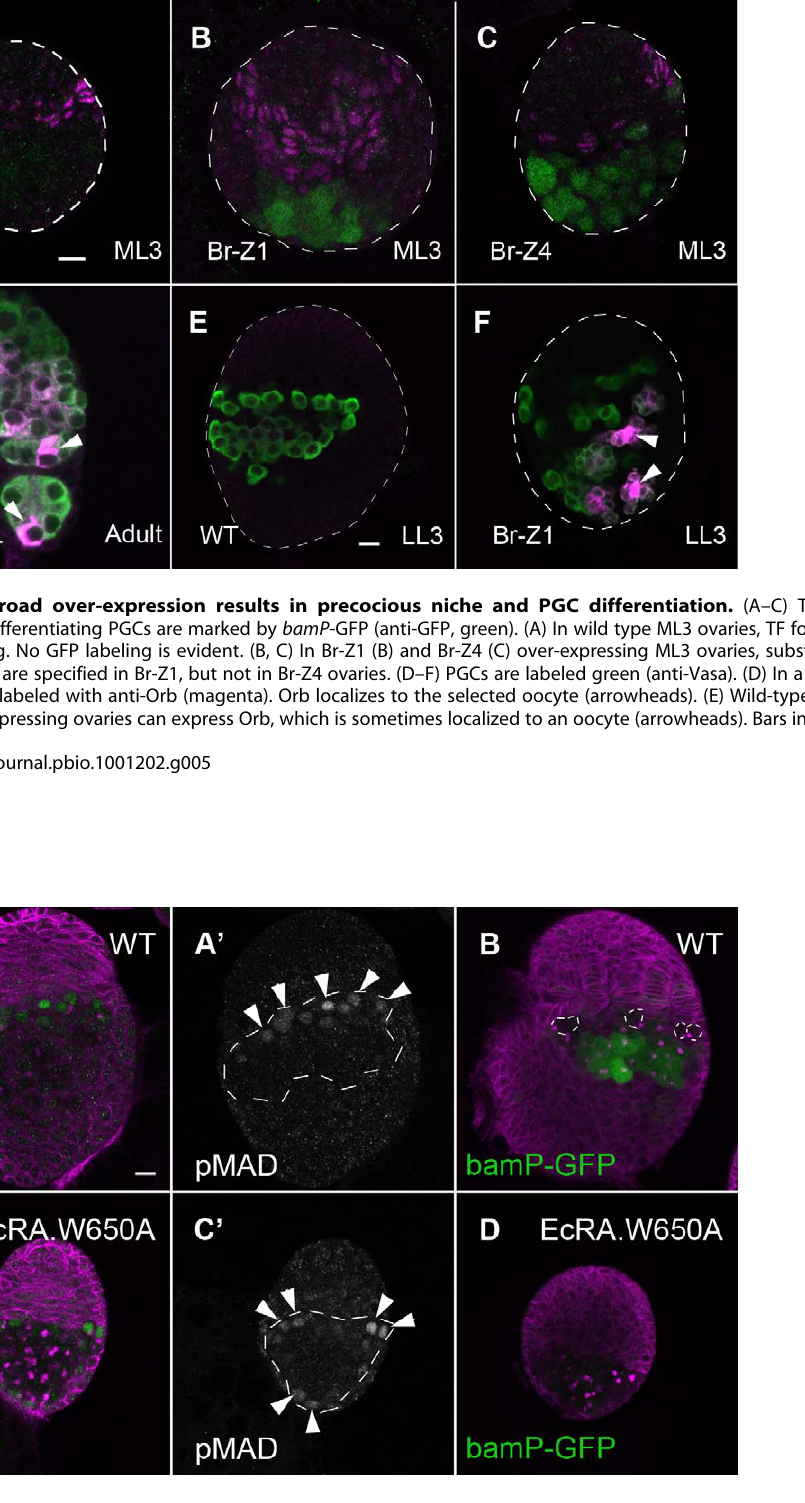
Figure 6. Ecdysone signaling is required for bam up-regulation in differentiating PGCs. All panels depict LL3 ovaries. 1B1 (magenta) outlines somatic cells and fusomes. (A) In wild type LL3 ovaries, only PGCs closest to the niche retain pMad labeling (anti-pMad, green). (A 9 ) is a grayscale image of the green channel. PGC region is outlined. pMAD positive PGC nuclei are marked by arrowheads. (B) PGCs that are located away from the niche and do not carry pMAD in their nuclei up-regulate bam ( bamP -GFP, green). PGCs located in niches do not express bamP -GFP (outlined). (C) In EcRA.W650A ovaries, some PGCs, which are close to anterior or posterior somatic cells, retain pMAD labeling. Most PGCs do not retain pMad staining. (C 9 ) is a grayscale image of the green channel. PGC region is outlined. pMAD positive nuclei are marked by arrowheads. (D) No corresponding elevation of bamP -GFP can be observed in EcRA.W650A ovaries. Bar in (A) for all panels is 10 m m.